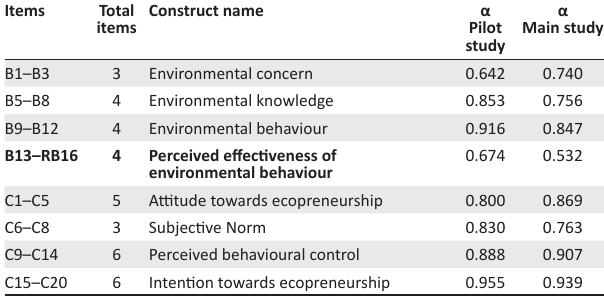
TABLE 3: Reliability